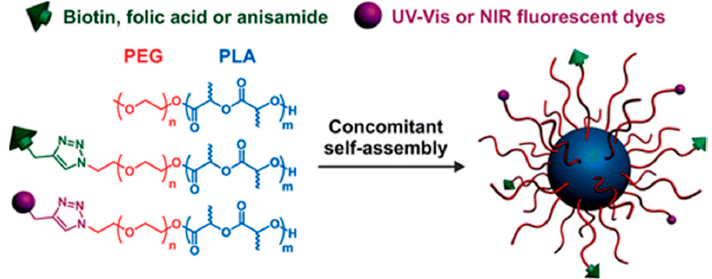
Figure 10. Multifunctional poly(ethylene glycol)-block-poly(lactic acid) (PEG- b -PLA) nanoparticles for cancer cell targeting and imaging [288].